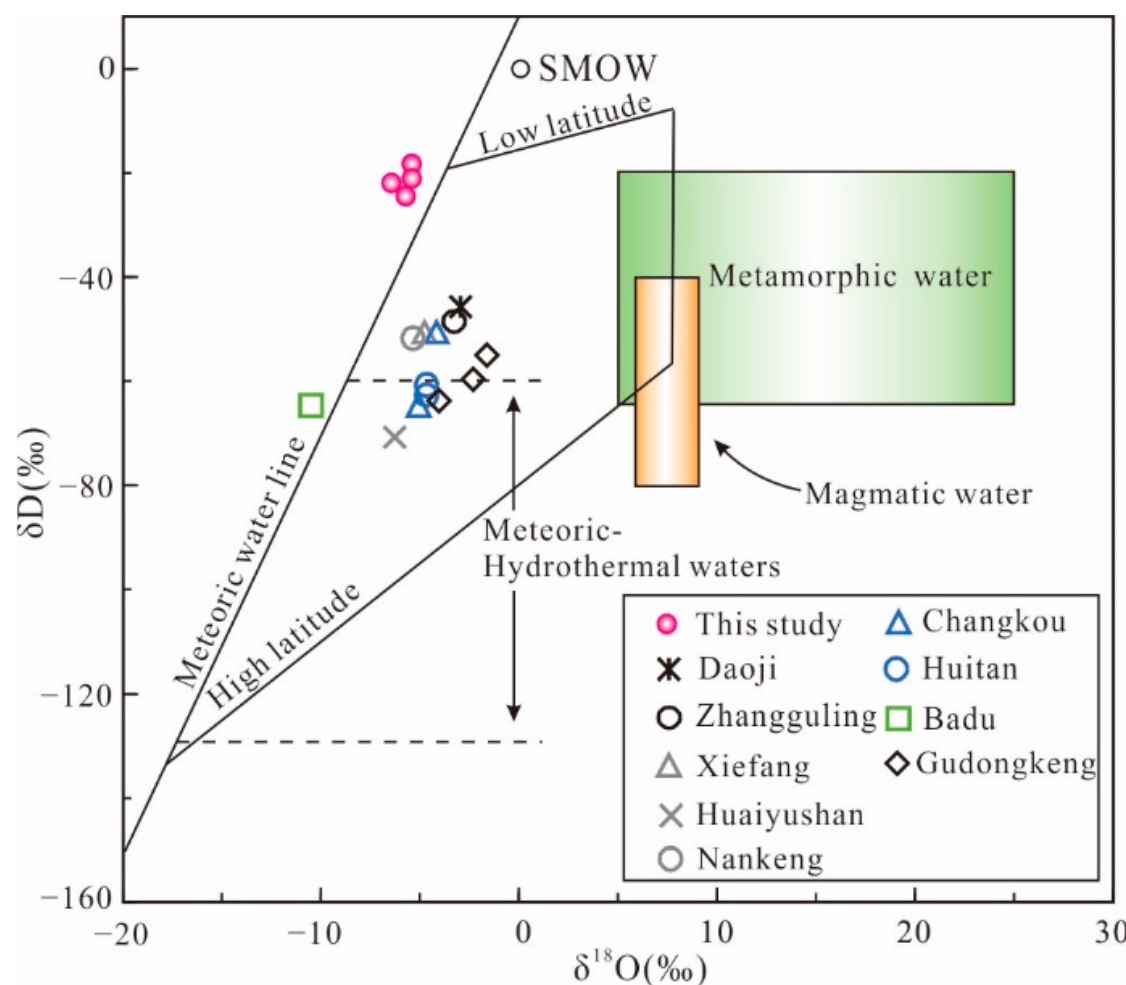
Figure 12. δ D- δ 18 O diagram of fluorite from the Shuanghuajiang fluorite deposit (modified after [75,80]. Data source: the Shuanghuajiang fluorite deposit is from this study; other deposits are from [77,78].